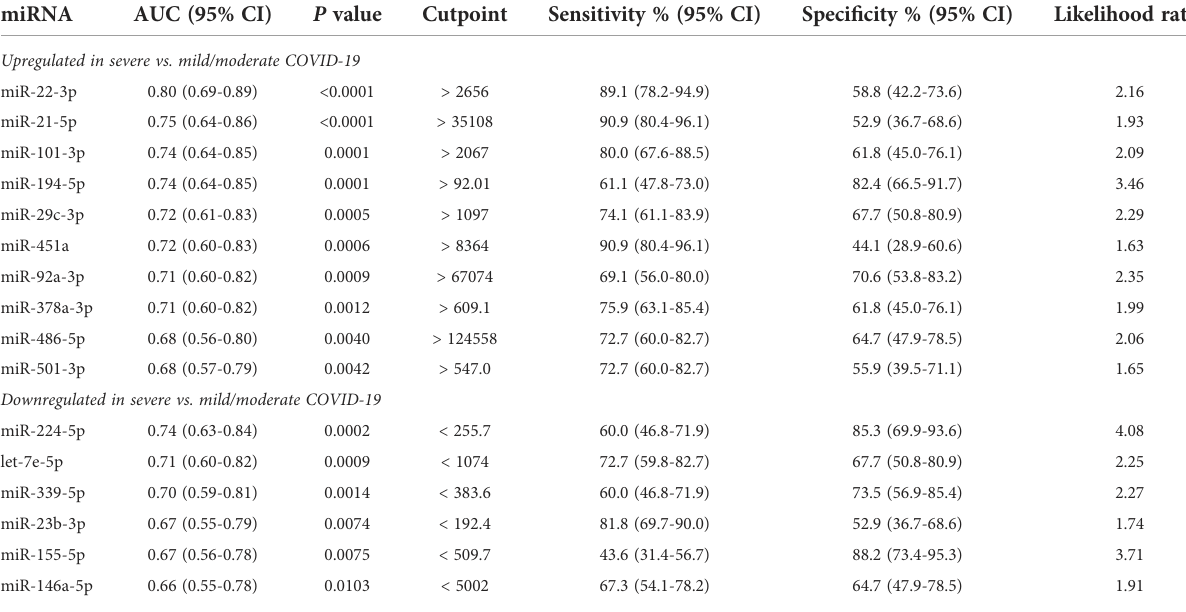
TABLE 3 ROC curve analysis of DE serum miRNAs in severe COVID-19 vs. mild and moderate